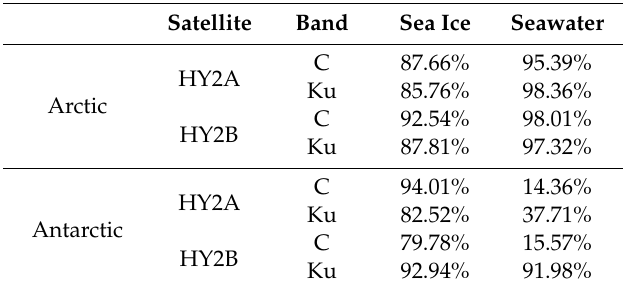
Table 4. Average classification accuracy rates.